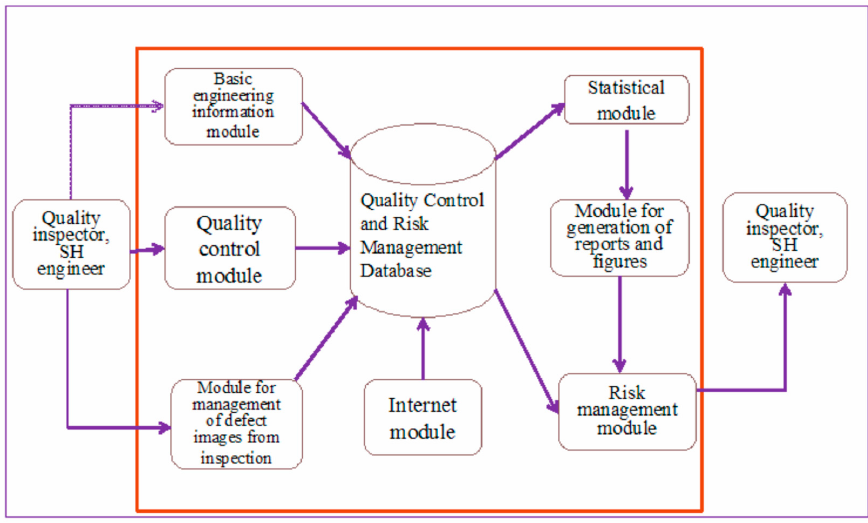
Figure 1. Model suggested by J. Chen and J. ‐ H. Chen [24] for risk management.